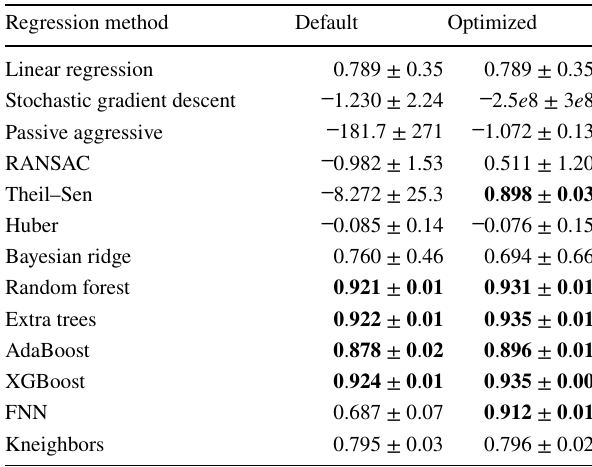
Table 1 Average coefficient of determination R 2 (and its standard deviation) for different regression methods, with default and opti- mized